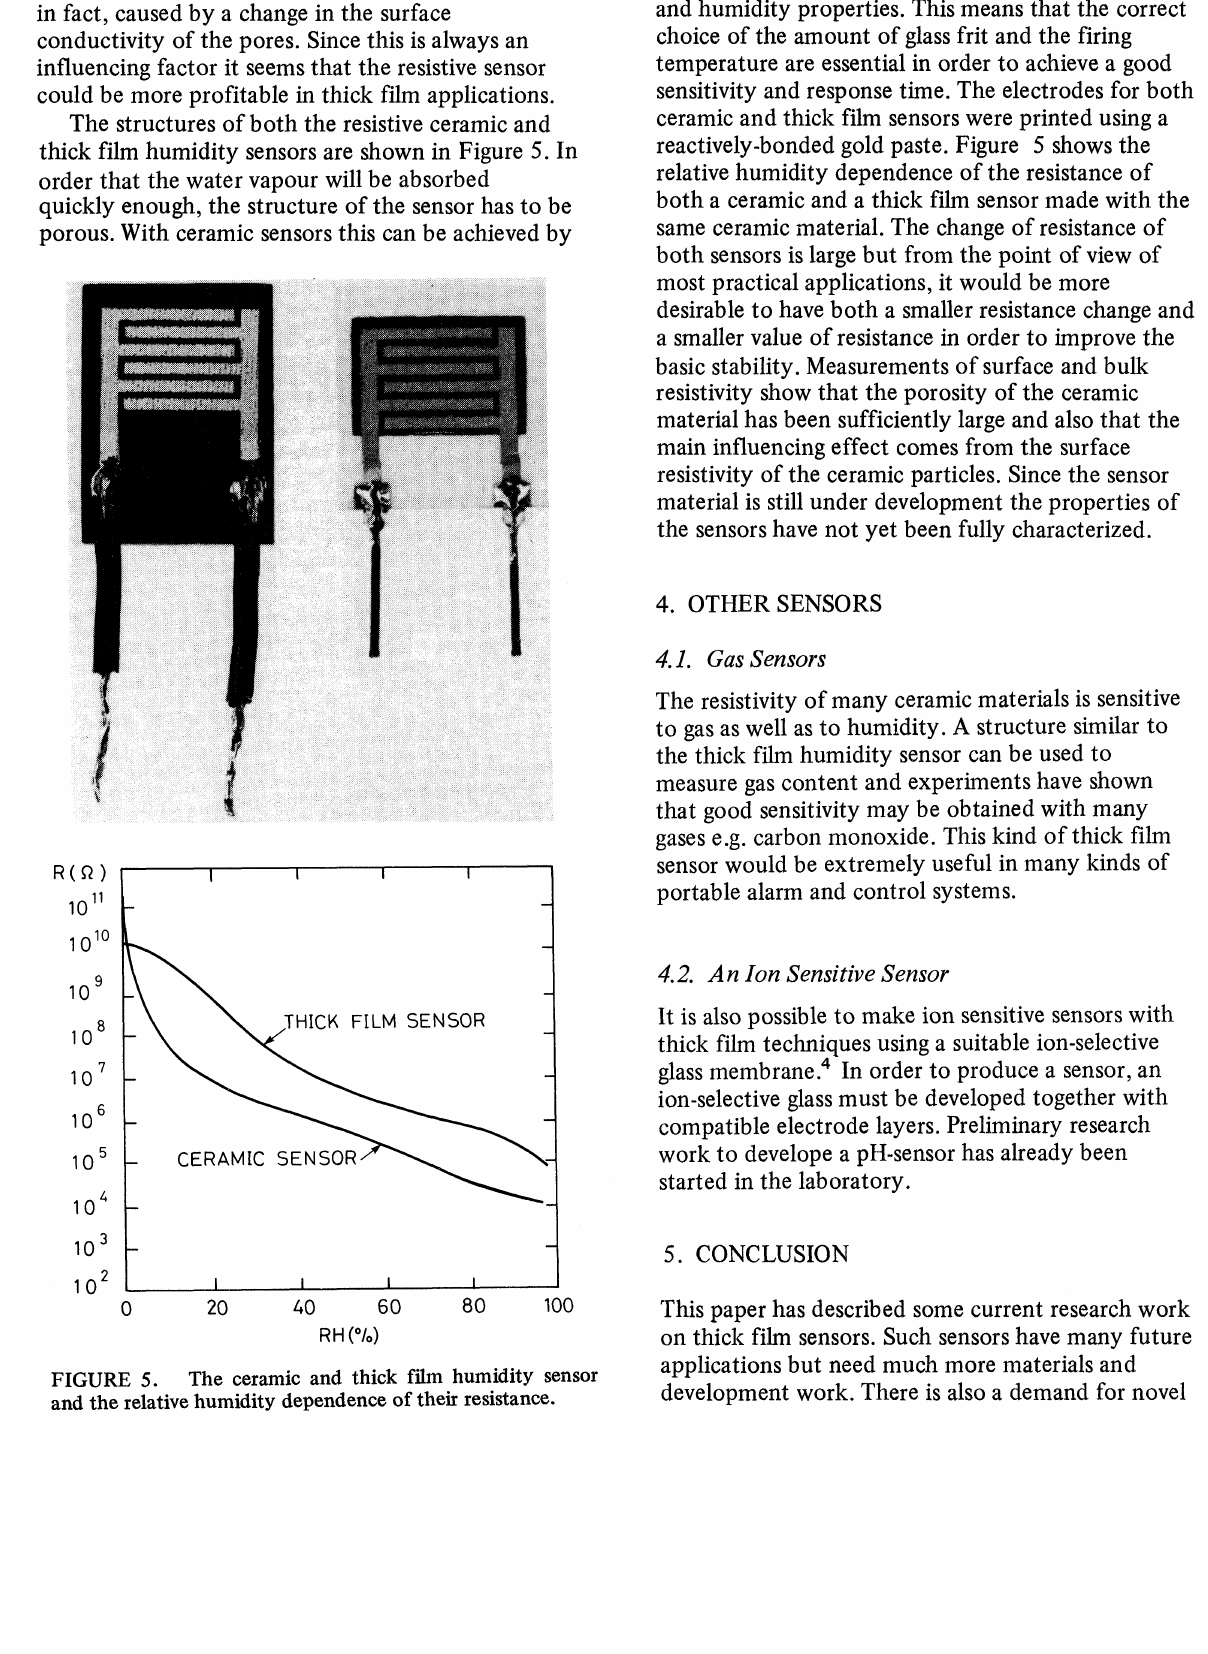
FIGURE 5. The ceramic and thick film humidity sensor and the relative humidity dependence of their